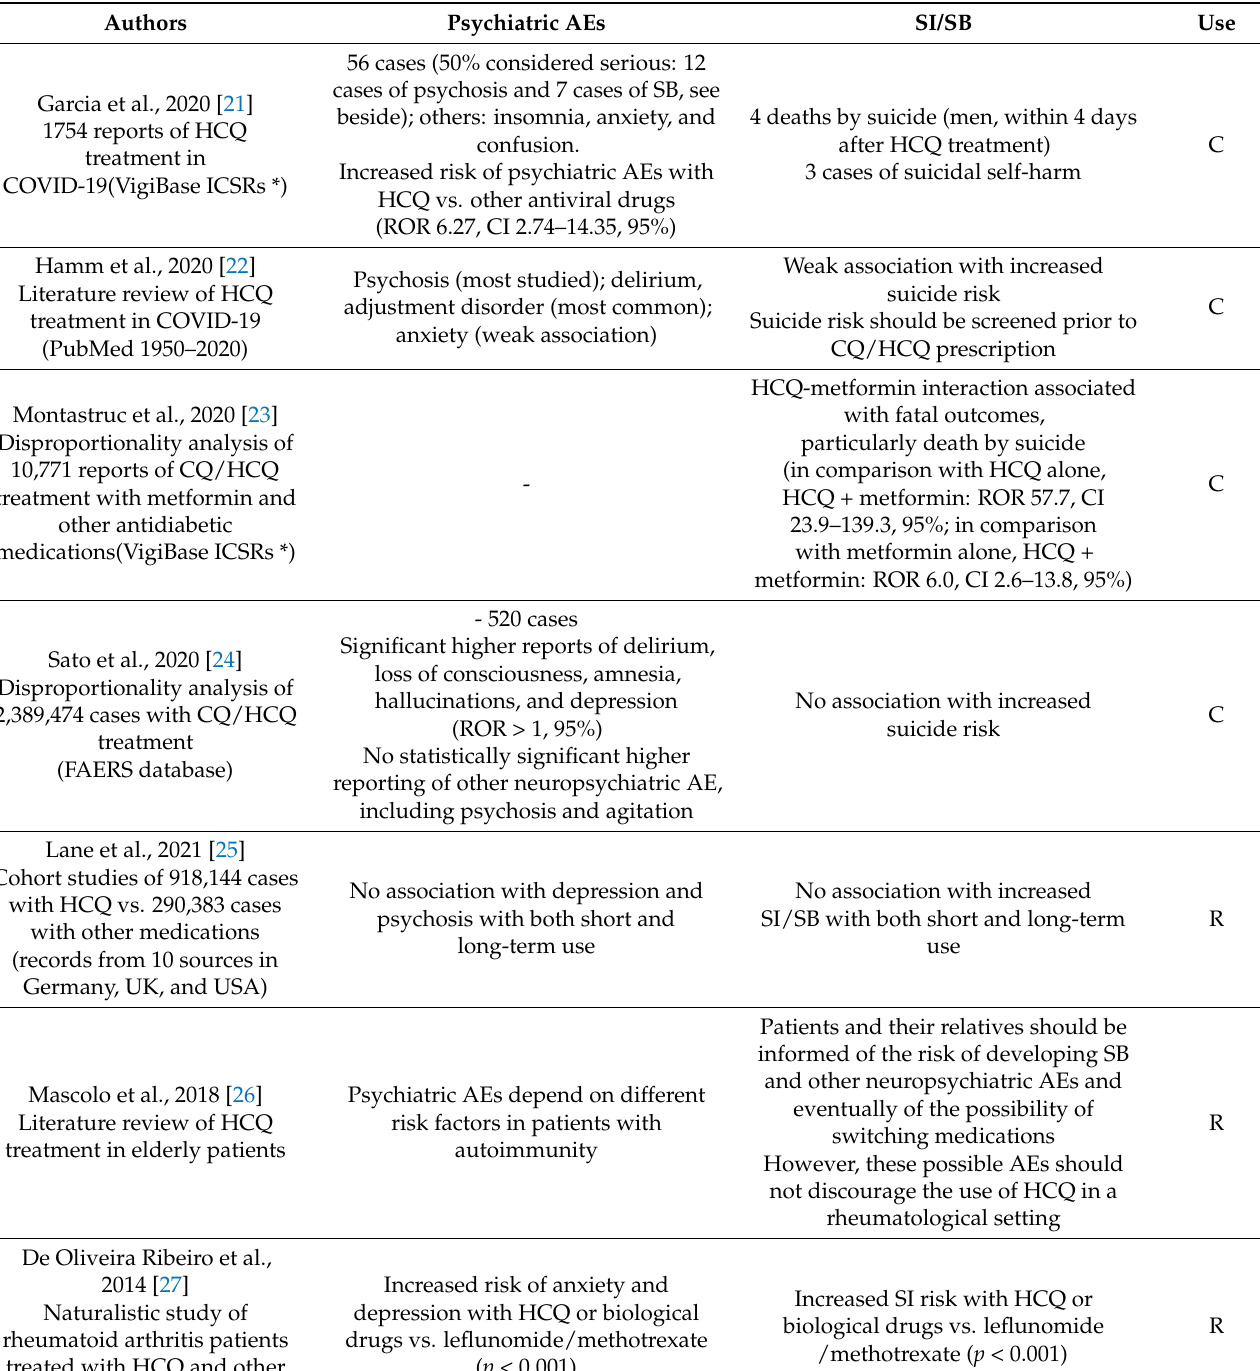
Table 1. Neuropsychiatric manifestations and SI/SB related to CQ/HCQ treatment (studies specifically investigating the possible association with SI/SB were